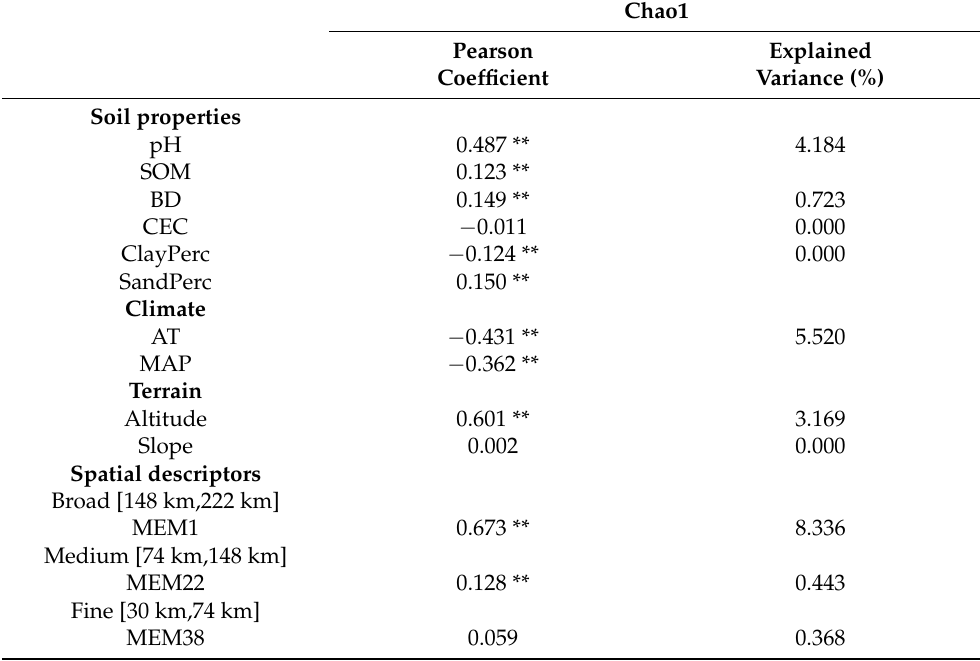
Figure 5. Variation partition. An UpSet plot showing the results from variation partitioning models that were used to identify the effects of soil properties, climate, and terrain and spatial descriptors. The dots below the bar represents the combination of different environmental variables. The black band represents explained variance of different environmental variables on soil bacterial abundance. The total explained variance of each part, such as the climate part, is shown on the left. Soil properties are pH, BD, CEC, and ClayPerc; climate is AT; terrain is altitude; spatial descriptors are MEM1, and MEM22, and MEM38. Table 2. Analysis of influencing factors of Chao1.These value are based on the 1810 sites analyzed. The impact of each indicator on soil bacteria is evaluated by Pearson test. Partial indicators are screened to participate in the variation partition.